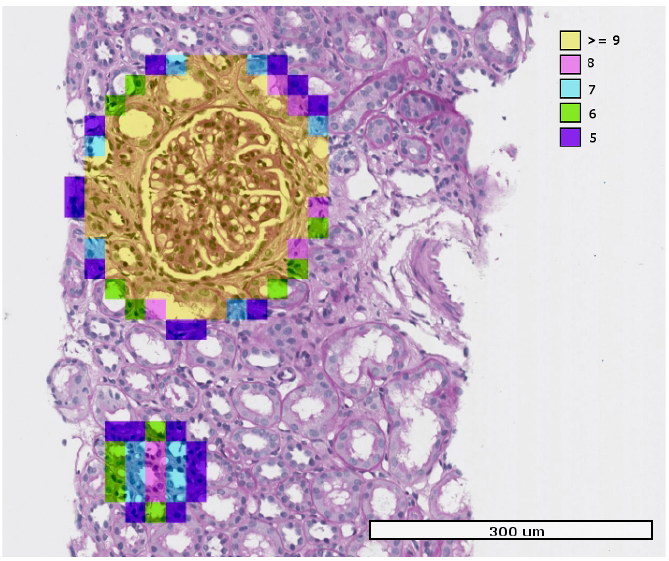
Figure 7. Redundancy map obtained in pixel classification. Displayed from overlapping 5 to overlapping ≥ 9. Table 2. Precision and Recall in Glomerulus detection according to Redundancy decision